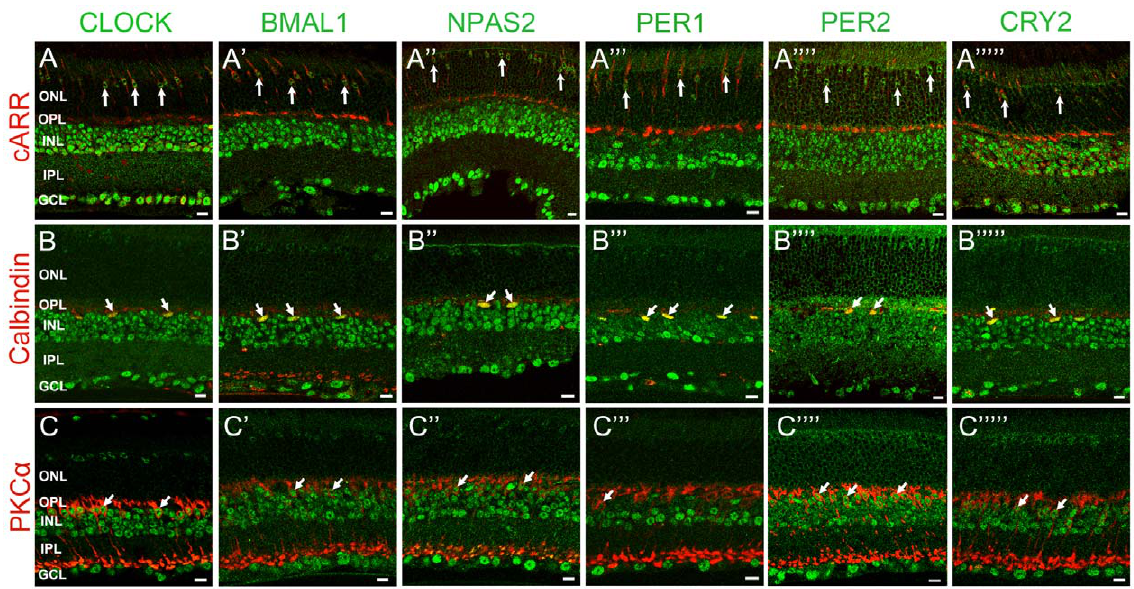
Figure 3. Mammalian core circadian clock protein expression in cones, horizontal cells and rod bipolar cells of the mouse retina. Typical examples of vertical sections of mouse retinas collected between ZT02 and ZT06 and double labeled for one of the following clock proteins: CLOCK ( A – C ), BMAL1 ( A ’– C ’ ), NPAS2 ( A ’’– C ’’ ), PER1 ( A ’’’– C ’’’ ), PER2 ( A ’’’’– C ’’’’ ), and CRY2 ( A ’’’’’– C ’’’’’ ) and one of the following protein markers: cARR (cones; A ), CALD28 (horizontal cells; B ), and PKC a (rod bipolar cells; C ). (see Table 1 for details about the antibodies). Note that in the outer nuclear layer (ONL) clock protein expression was evident in cones but was weak or absent in rods. Some double-labeled retinal neurons are shown (arrows). OPL: outer plexiform layer; INL: inner nuclear layer; IPL: inner plexiform layer. Optical sections 3 6 0.4 m m. Bar is 10 m m.